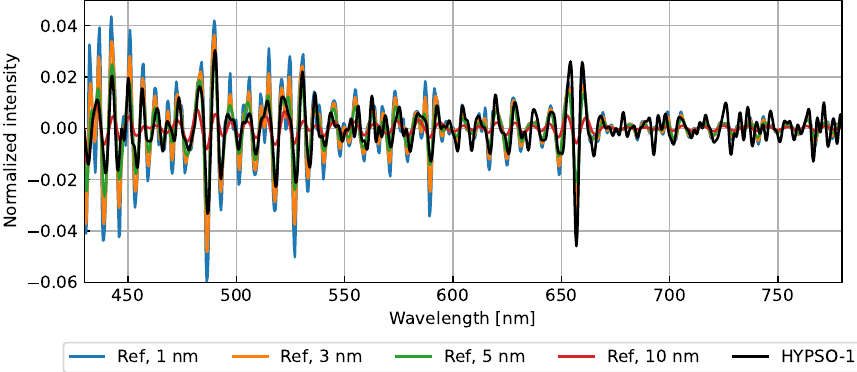
Figure 10. Comparison with reference spectra. HYPSO-1 data (black) and solar spectrum at different simulated spectral resolutions (shades of blue), after filtering and